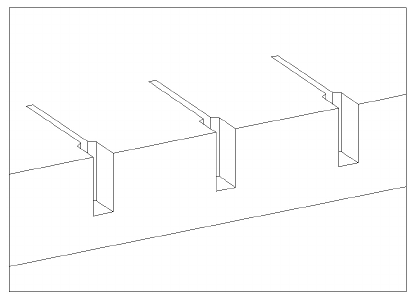
Figure 1. Narrow mouth top dowel